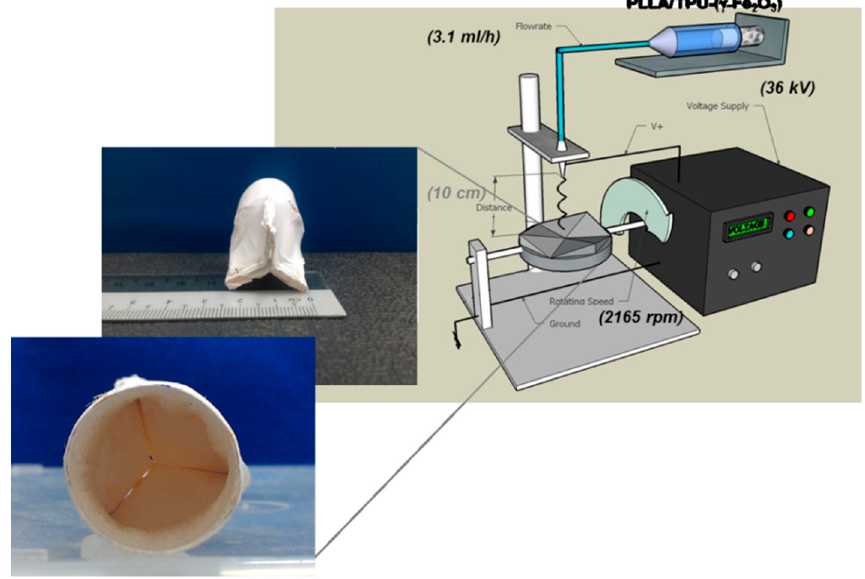
Figure 5. Schematic of electrospinning setup, interior and exterior images of 3D fabricated scaffold.